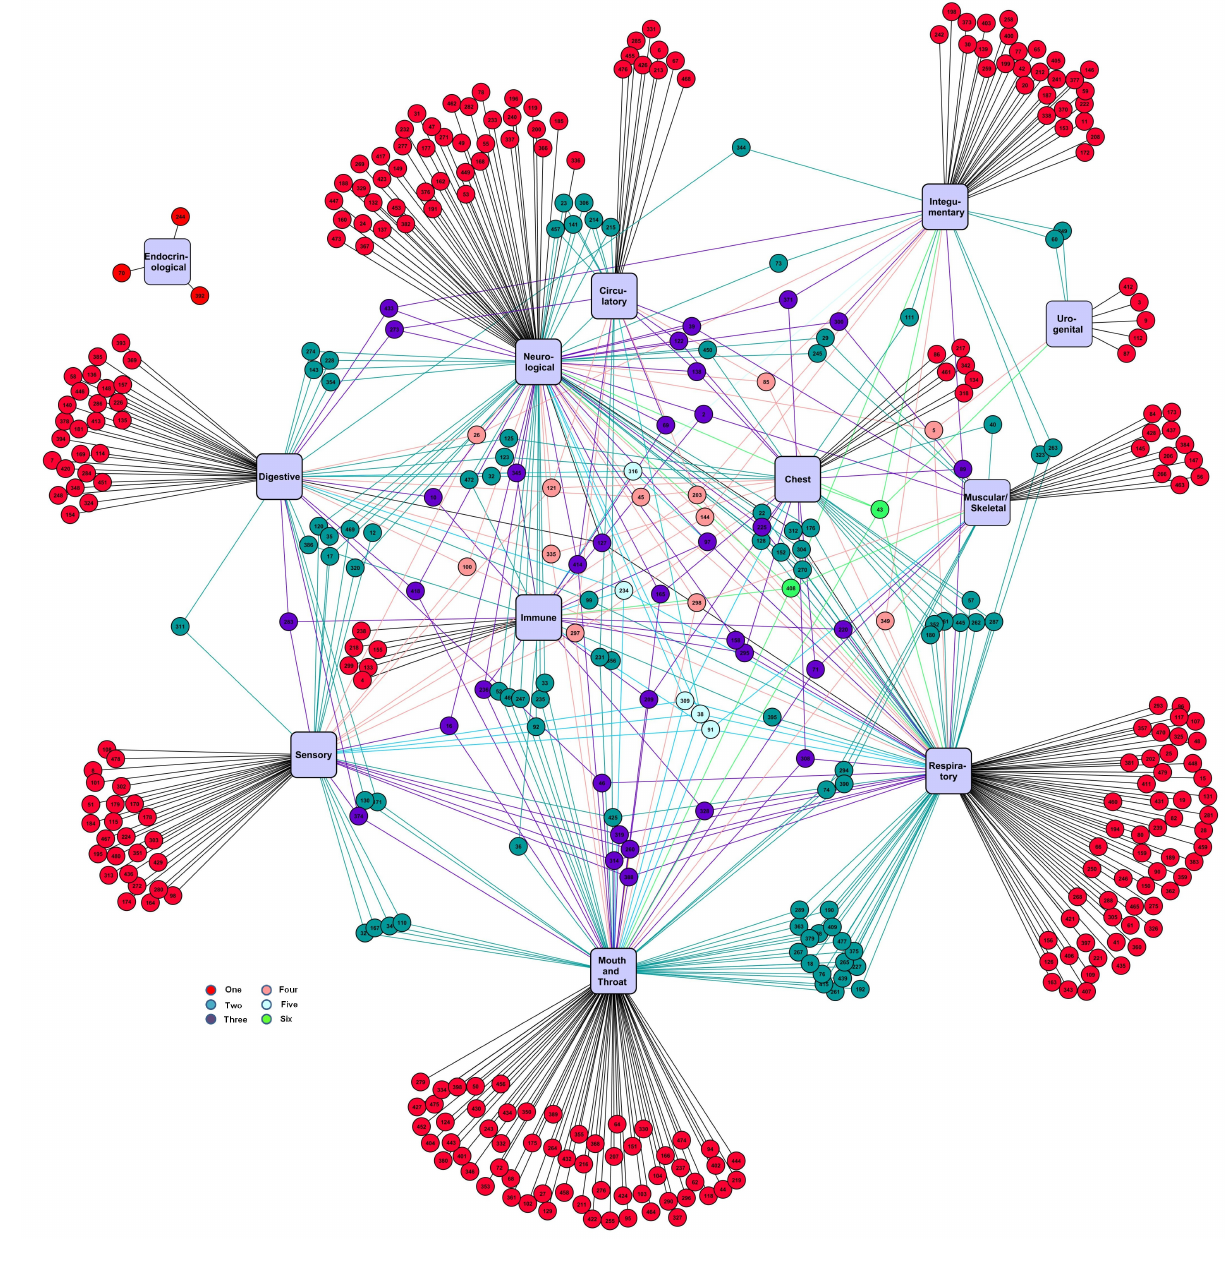
Figure 3. Interactome showing relationship between users who reported negative symptoms and the systems that were